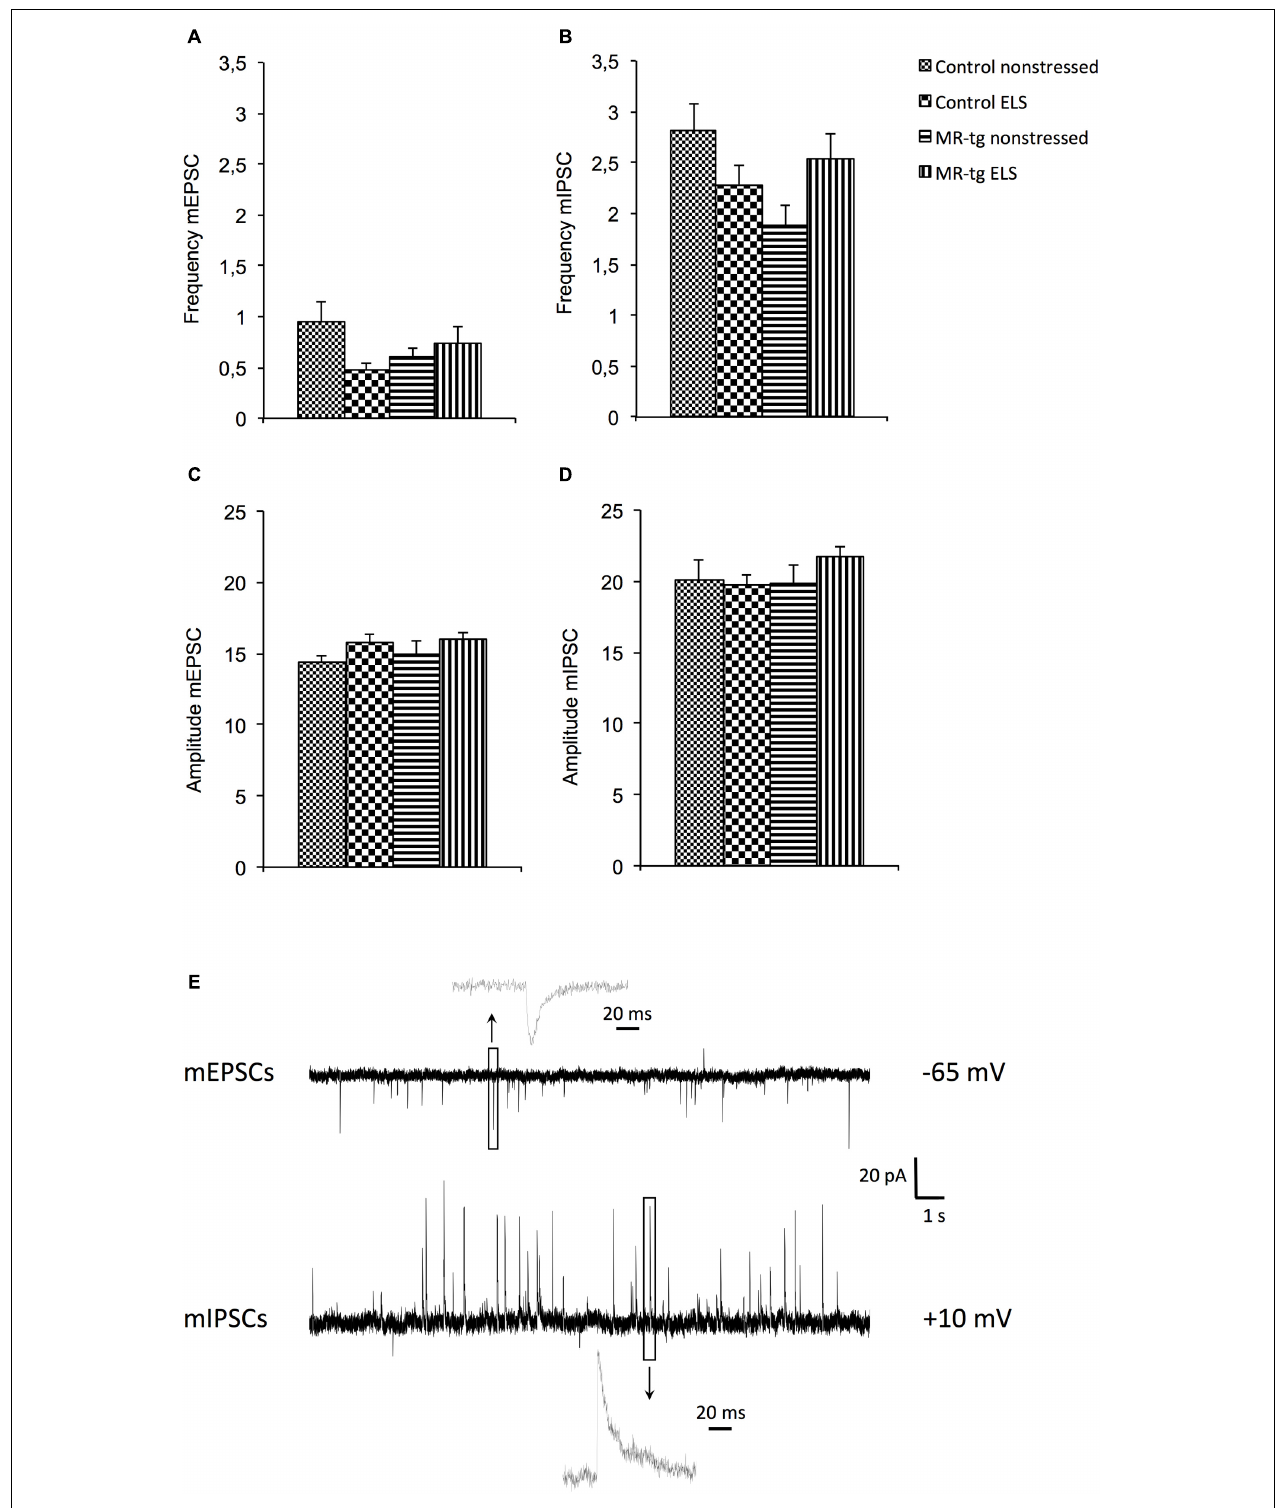
FIGURE 6 | Electrophysiological recordings in MR-tg and control (wildtype) mice, with or without early life stress (ELS). (A) Effects on the frequency of (A) mEPSCs, and (B) mIPSCs, (C) amplitude of mEPSCs and (D) mIPSCs. Data are expressed as mean ± SEM, n = 11 cells per group. Traces (E) show typical examples of mEPSCs (top) and mIPSCs (bottom) recorded from a dentate granule cells at the holding potential mentioned at the right. Insets illustrate single events at a high time resolution.